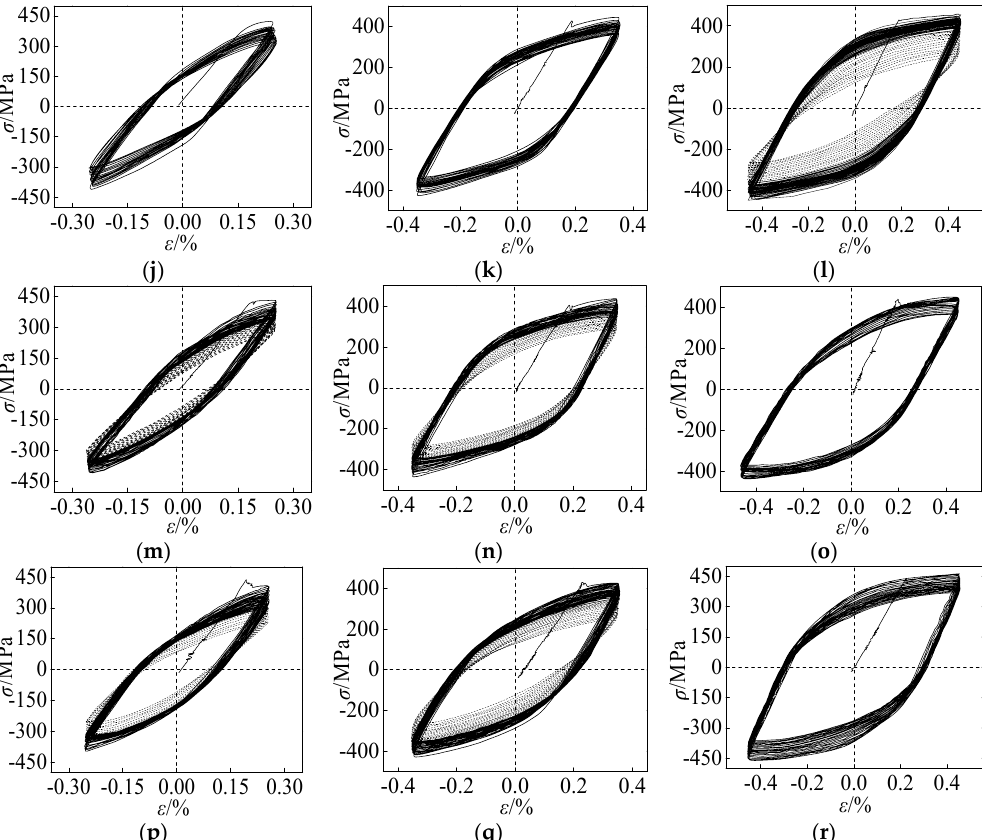
Figure 6. Stress-strain ( σ - ε ) hysteresis curve of the welded specimen. ( a ) WA1 (1) ε max = 0.25%; ( b ) WA1 (2) ε max = 0.35%; ( c ) WA1 (3) ε max = 0.45%; ( d ) WA2 (1) ε max = 0.25%; ( e ) WA2 (2) ε max = 0.35%; ( f ) WA2 (3) ε max = 0.45%; ( g ) WA3 (1) ε max = 0.25%; ( h ) WA3 (2) ε max = 0.35%; ( i ) WA3 (3) ε max = 0.45%; ( j ) WB1 (1) ε max = 0.25%; ( k ) WB1 (2) ε max = 0.35%; ( l ) WB1 (3) ε max = 0.45%; ( m ) WB2 (1) ε max = 0.25%; ( n ) WB2 (2) ε max = 0.35%; ( o ) WB2 (3) ε max = 0.45%; ( p ) WB3 (1) ε max = 0.25%; ( q ) WB3 (2) ε max = 0.35%; ( r ) WB3 (3) ε max = 0.45%.